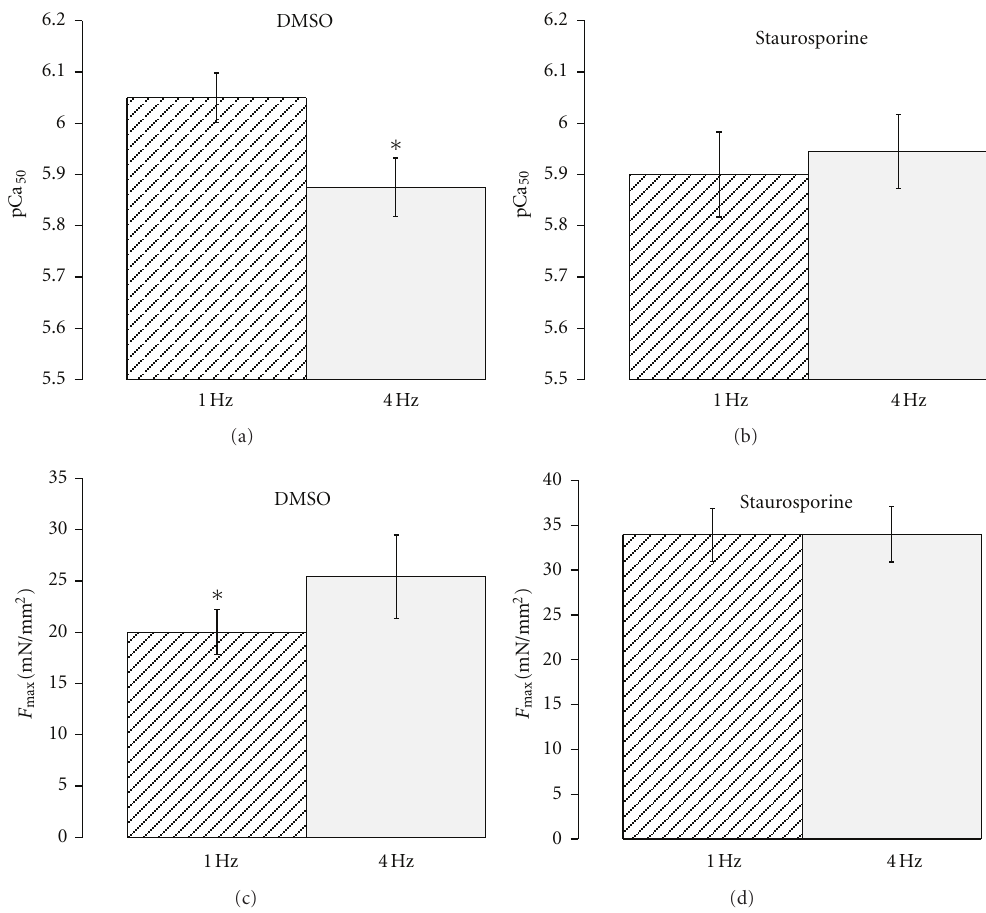
Figure 4: Average pCa 50 and maximum force ( F max ) data obtained from the force calcium relationships ( n = 10 for DMS and n = 9 for staurosporine). A significant di ff erence ( P < 0 . 05 denoted with ∗ ) was seen in the pCa 50 and F max between the 1 and 4Hz under control conditions (panels (a) and (b)). These shifts in sensitivity and F max were eliminated by staurosporine (panels (c) and